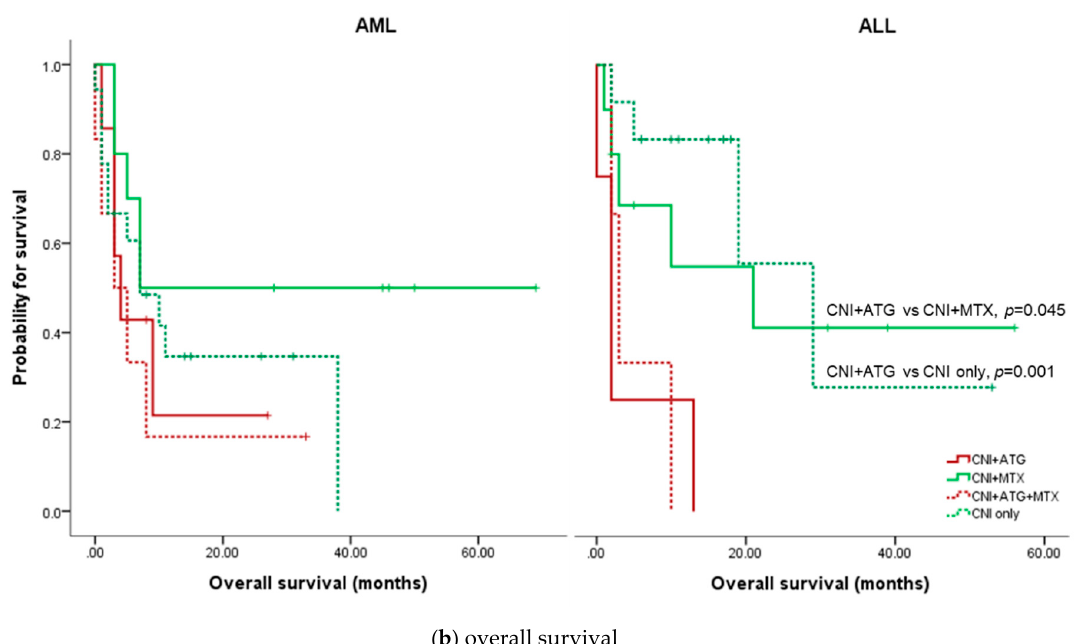
Figure 3. Survival according to graft-versus-host disease (GVHD) prophylaxis regimen.